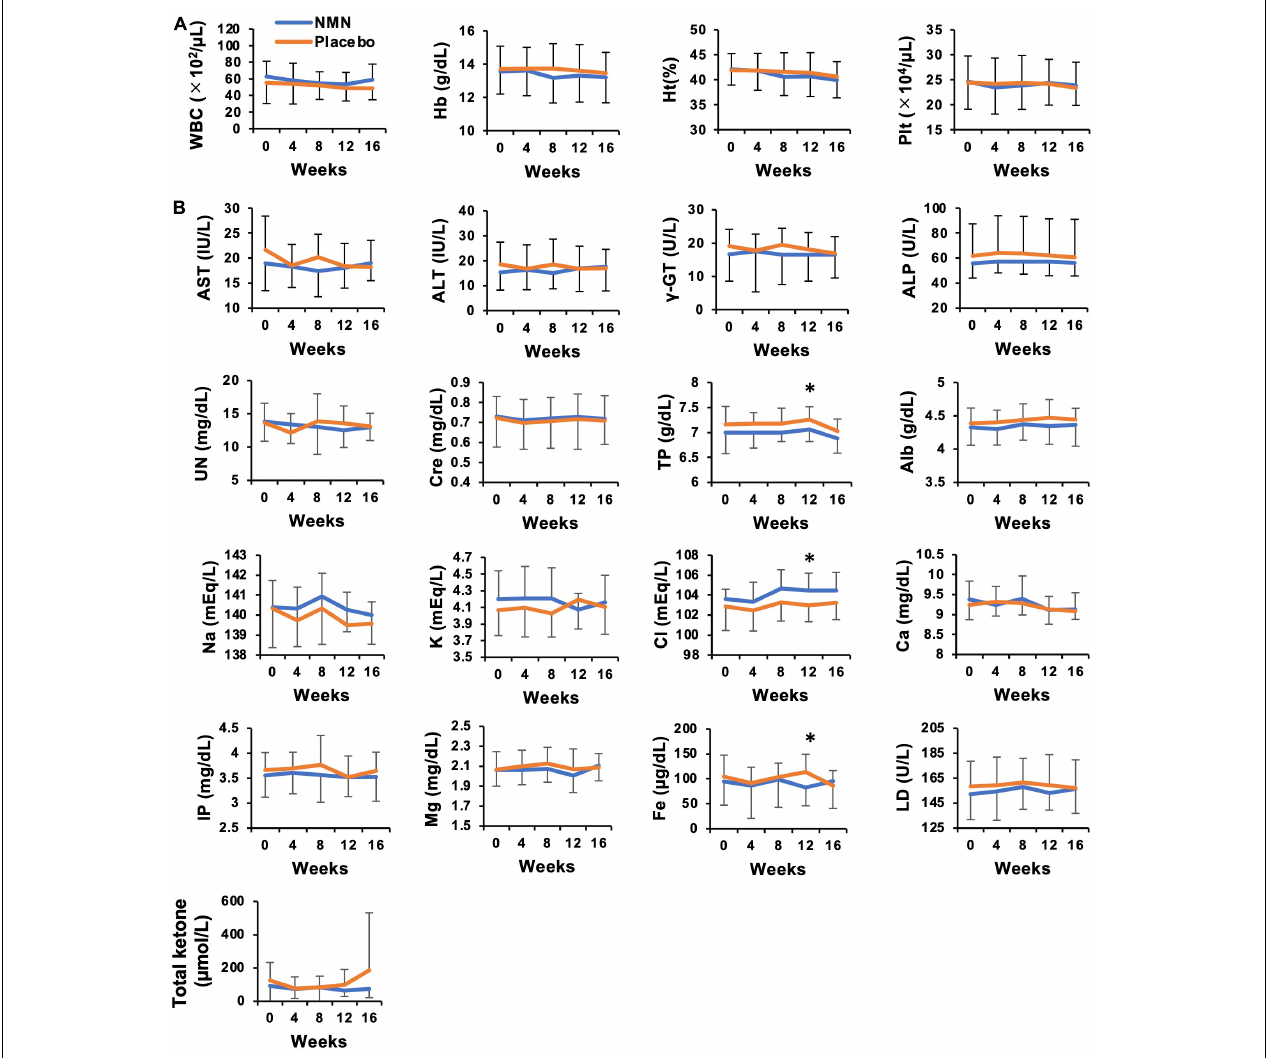
FIGURE 3 | No adverse event was observed in laboratory data for safety evaluation of NMN oral administration. Hematological (A) and biochemical (B) blood tests were performed every 4 weeks. Orange represents placebo group ( n = 15 at 0, 4, 8 weeks, n = 14 at 12, 16 weeks) and blue represents NMN group ( n = 15). Data are represented as mean ± SD. WBC, white blood cells; Hb, hemoglobin; Ht, hematocrit; Plt, platelets; AST, aspartate aminotransferase; ALT, alanine aminotransferase; γ -GT, gamma-glutamyl transferase; ALP, alkaline phosphatase; UN, urine nitrogen; Cre, serum creatinine; TP, total protein; Alb, albumin; Na, serum sodium; K, serum potassium; Cl, serum chloride; Ca, serum calcium; Mg, serum magnesium; Fe, serum iron; IP, inorganic phosphorus; LD, lactate dehydrogenase. Asterisk means statistical significance: p -value <